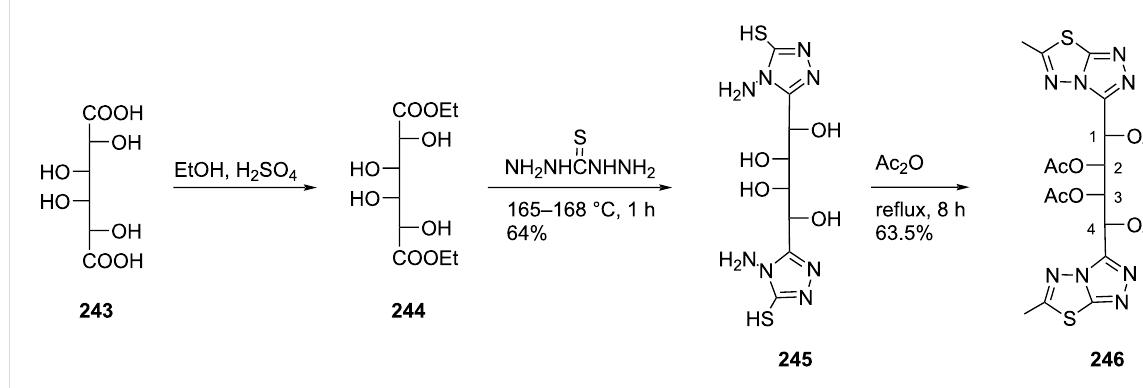
Scheme 64: Synthesis of double-headed acyclo C -nucleoside 246 .